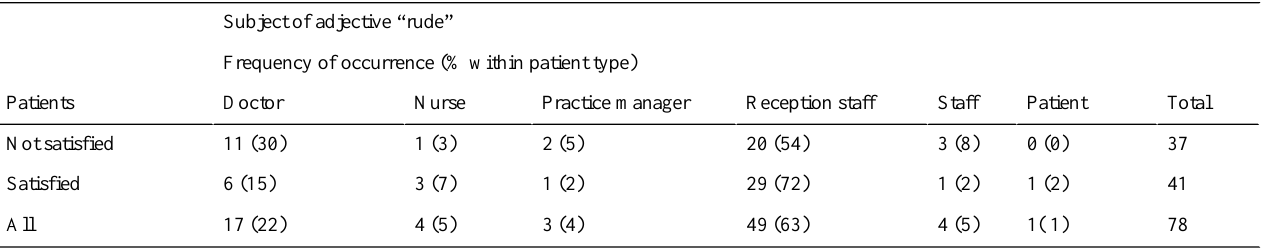
Table 2. Keyword in Context (KWIC) analysis for the word “rude”. Frequency of occurrence (% within patient type) by patient satisfaction and subject. Subject of adjective